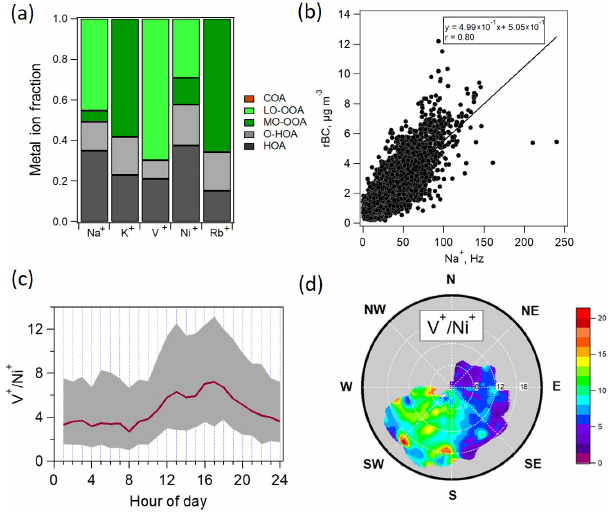
Figure 5. (a) Fractions of the trace metal ions contributed by each OA component obtained from the PMF analysis with OA, rBC, and metal ions measured by the laser-on mode as model inputs. (b) Scat- ter plot of 5min averaged rBC concentrations vs. Na + signals. (c) Diurnal cycle of the V + / Ni + ratio (the 25th and 75th percentiles are shown using the shaded area). (d) NWR plot of the V + / Ni + ra- tio over the entire